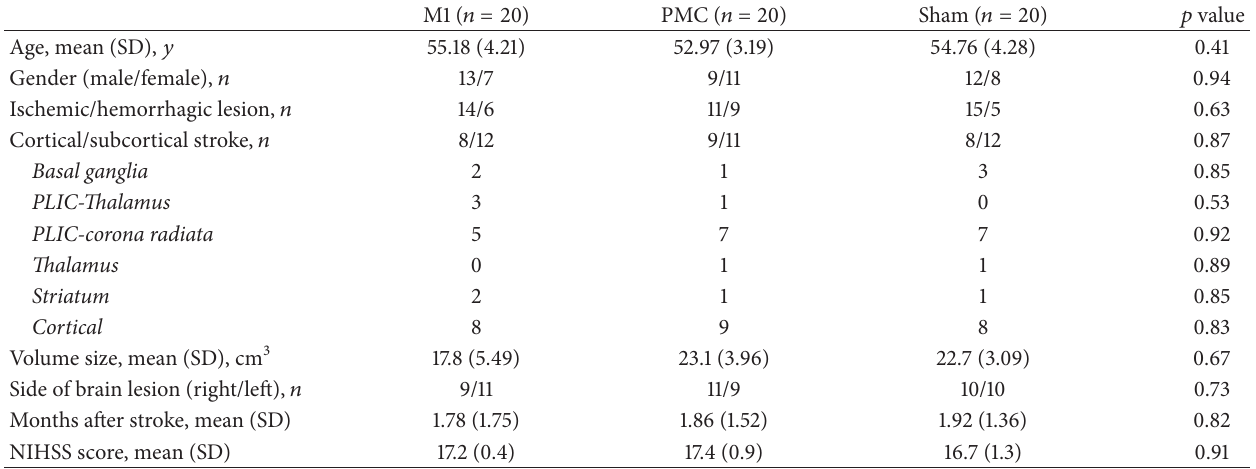
Table 1: Clinical and sociodemographic characteristics of participants at